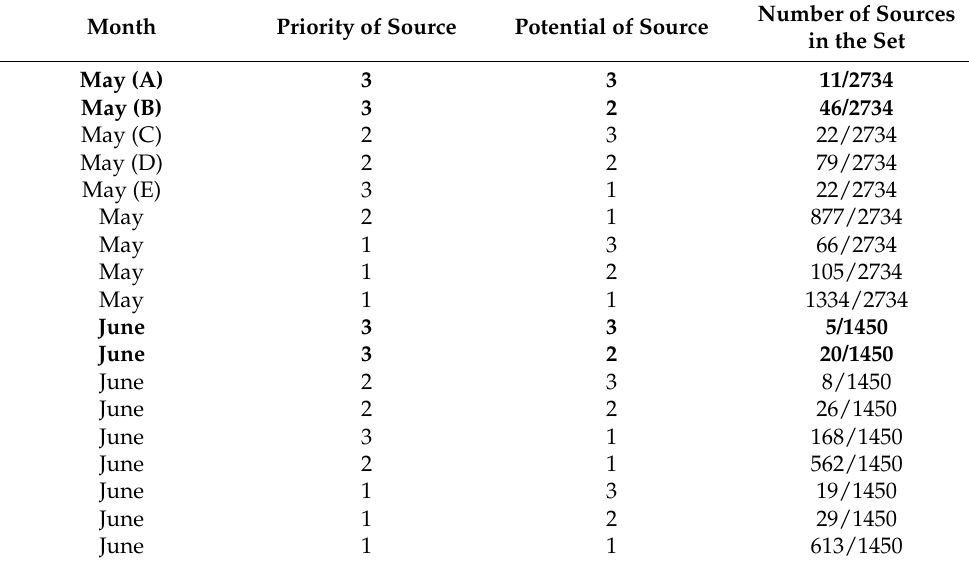
Table 3. Ranked sources of information diffusion by